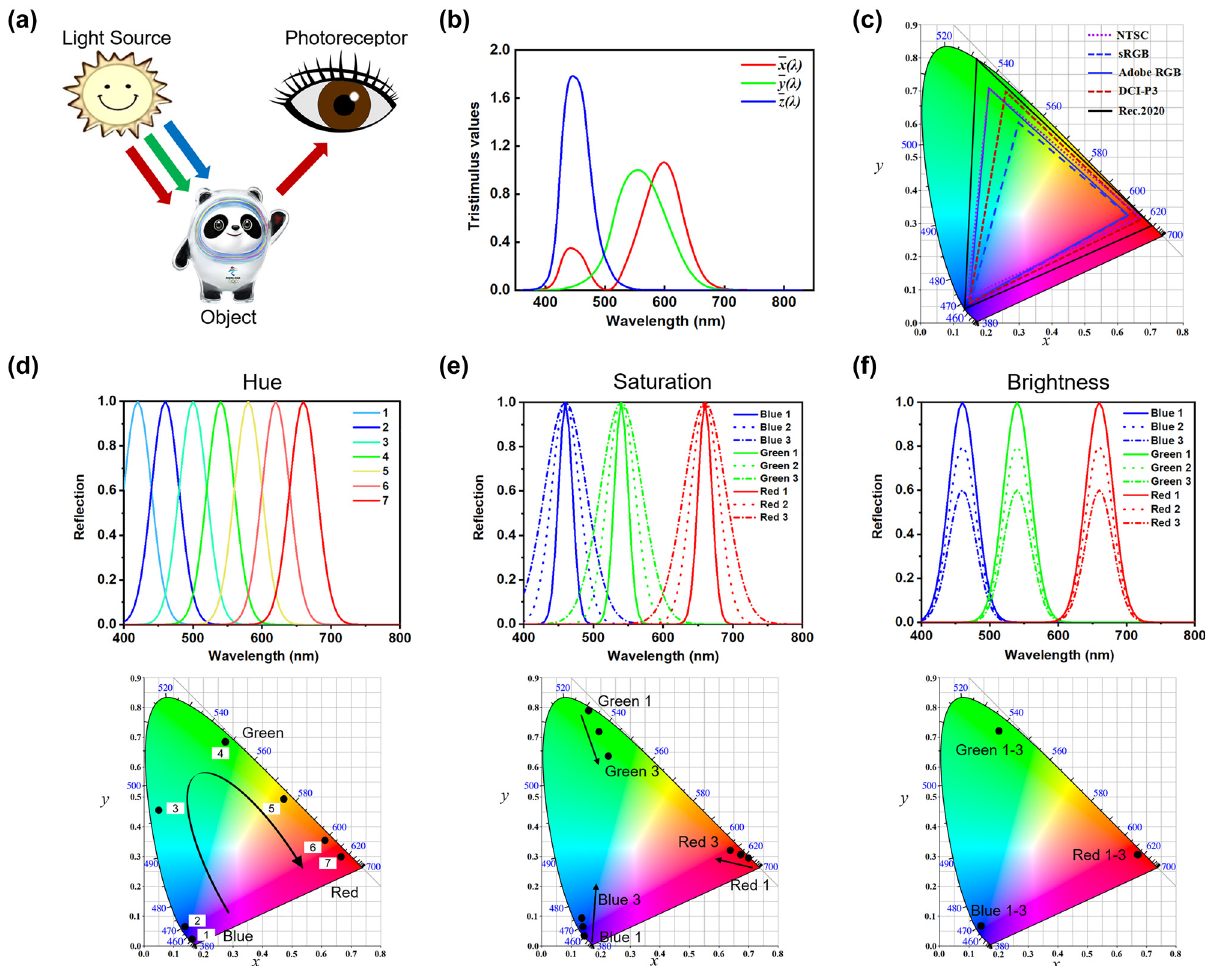
Figure 2: CIE 1931 XYZ color space. (a) Schematic diagram of the color perception process, where the object (Bing Dwen Dwen) reflects, transmits, or absorbs certain amount of the incident EM waves through various physical and chemical processes. The subsequently reflected (transmitted) light is received by the photoreceptors on human retina, generating signals to the visual cortex for the final color perception. (b) Color matching functions ( ) 𝜆 x ( 𝜆 ), y and z ( 𝜆 ). (c) The CIE 1931 XYZ chromaticity diagram and five popular color gamut standards. (d) Reflection spectra with different central wavelengths (upper panel) and the corresponding coordinates in the CIE XYZ color space (lower panel) to illustrate the hue property of a color. (e) Reflection spectra with different bandwidths (upper panel) and the corresponding coordinates in the CIE XYZ color space (lower panel) to illustrate the saturation property of a color. (f) Reflection spectra with different peak intensities (upper panel) and the corresponding coordinates in the CIE XYZ color space (lower panel) to illustrate the brightness property of a